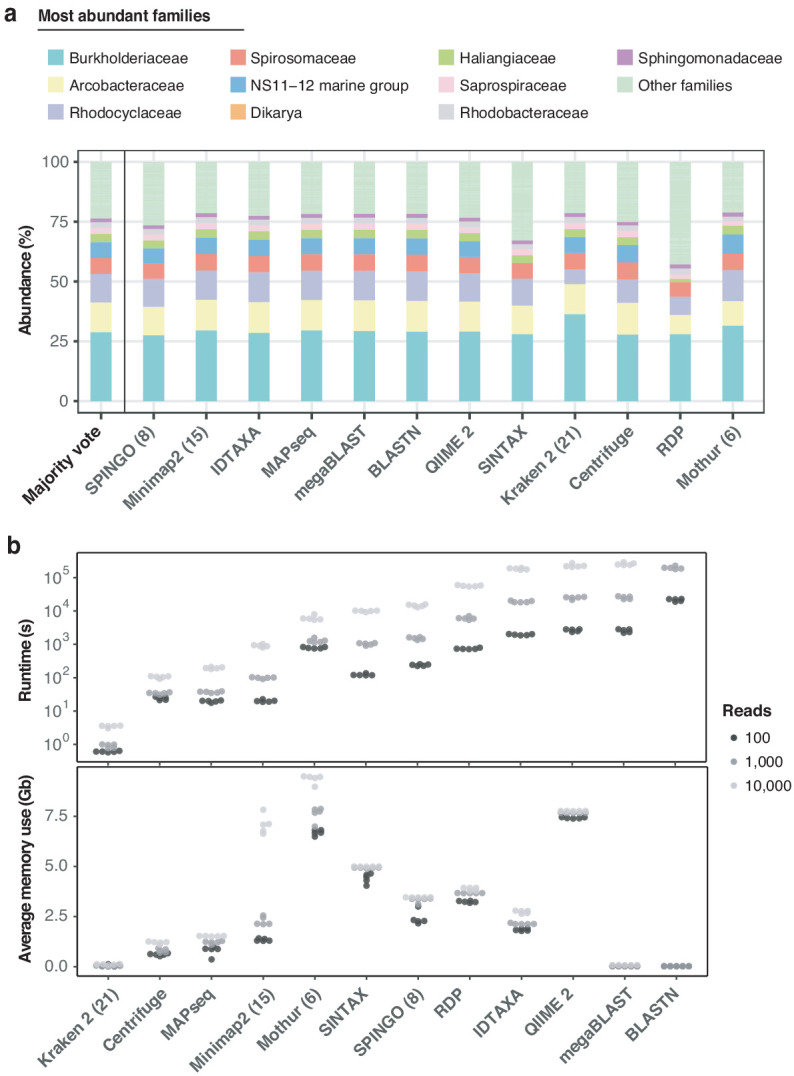
Benchmarking of twelve taxonomic classifiers with nanopore full-length 16S sequences.(a) Top 10 represented bacterial taxon families across all methods, based on the 10,000 aquatic reads used in Figure 2d. (b) Comparison of computational performances with respect to (upper) runtime and average memory (lower) usage for the classification of 5 × 100, 5 × 1000, and 5 × 10,000 random read draws of the same sample. BLASTN-based classifications of 10,000 read sets are omitted, as their runtimes exceeded 14 days (> 106 s). Numbers in brackets for SPINGO, Minimap2, Kraken 2 and Mothur indicate kmer sizes.